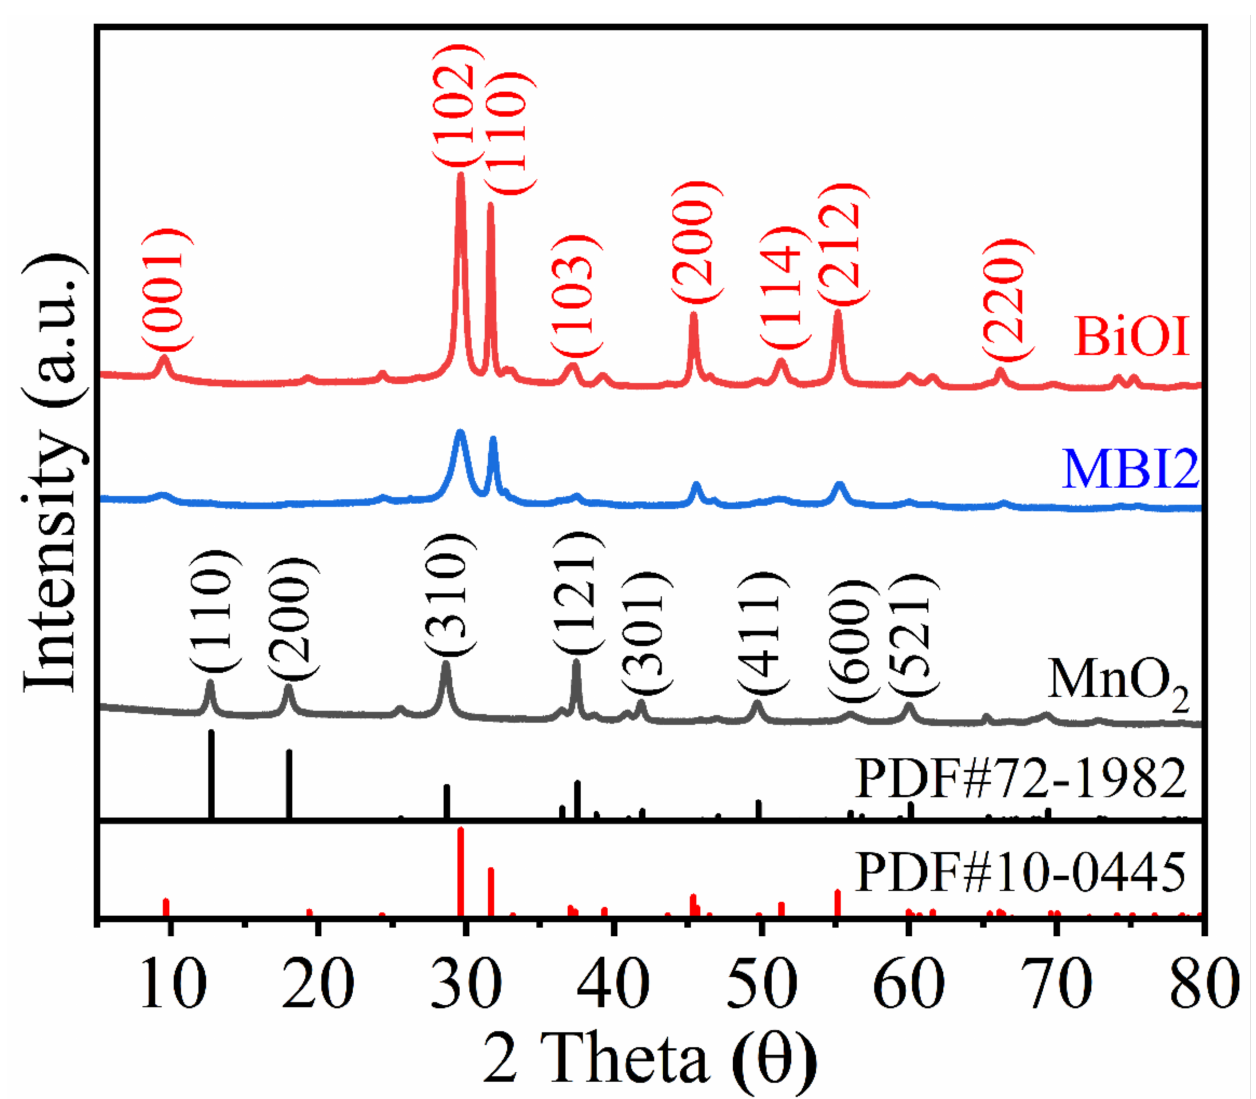
Figure 3. XRD patterns of pure α -MnO 2 , pure BiOI, and MBI2( α -MnO 2 /BiOI) composites. By using infrared spectroscopy, the chemical structures of composites made of α - MnO 2 , BiOI, and MBI2 were further examined. The acquired samples’ infrared spectra are displayed in Figure 4. The three strong characteristic absorption peaks appearing at 3456, 1668, and 1625 cm − 1 correspond to the stretching and bending vibrations of the O-H bond in the H 2 O adsorbed by the as-prepared material, respectively. In addition, more detailed results can be obtained from the amplified IR spectra in the range of 400~1500 cm − 1 (red dashed line corresponds to BiOI and black dashed line to α -MnO 2 ). For α -MnO 2 , the peaks at 720, 600, 522, and 465 cm − 1 are attributed to the stretching vibrations of the Mn-O bond [36]. For the BiOI samples, the peaks at 483 and 512 cm − 1 correspond to the Bi-O bond, while the peak at 767 cm − 1 is attributed to the I-O bond. The peaks at 1421 and 1292 cm − 1 are also attributed to the O-H bond [37]. In addition, all major characteristic absorption peaks of α -MnO 2 and BiOI can be observed in the spectra of MBI2 composites. This confirms that α -MnO 2 and BiOI have been successfully coupled